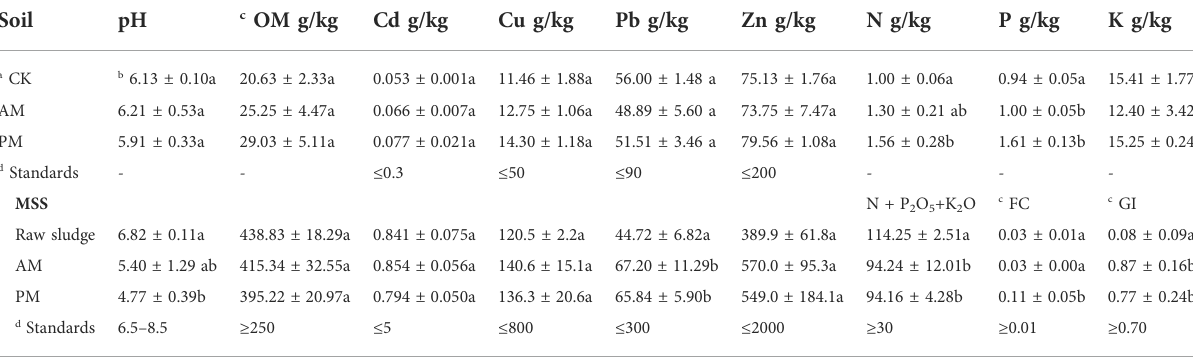
TABLE 4 Characteristics of soils and municipal sewage sludge (MSS) after